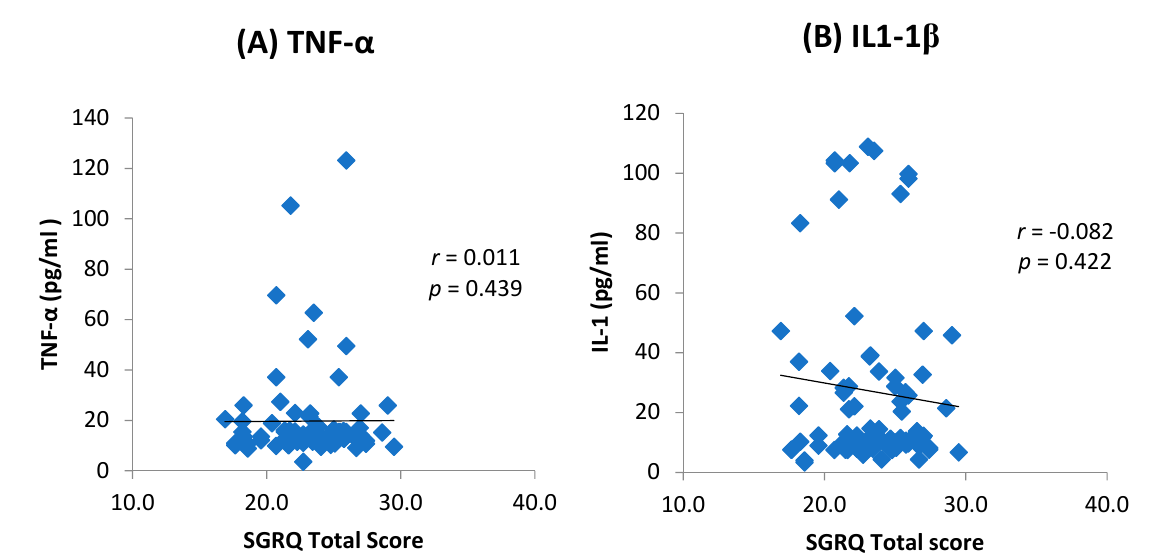
Figure 6. Correlation between Six min walk test and levels of ( A ) TNF- α (pg/mL) and ( B ) IL-1 β (pg/mL) among the cases.